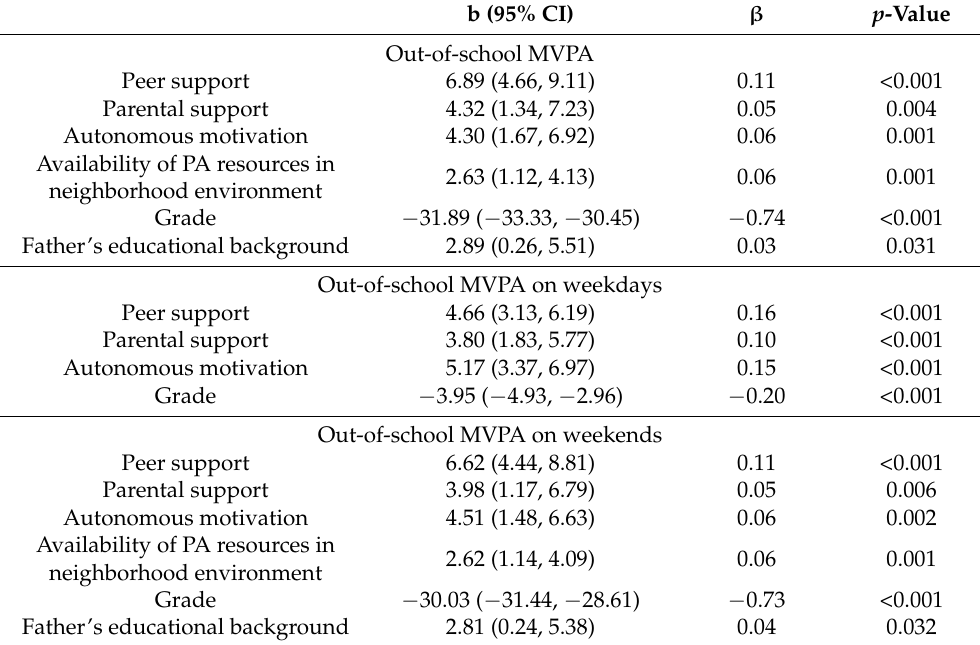
Table A2. Multiple regression analysis for out-of-school MVPA among girls.